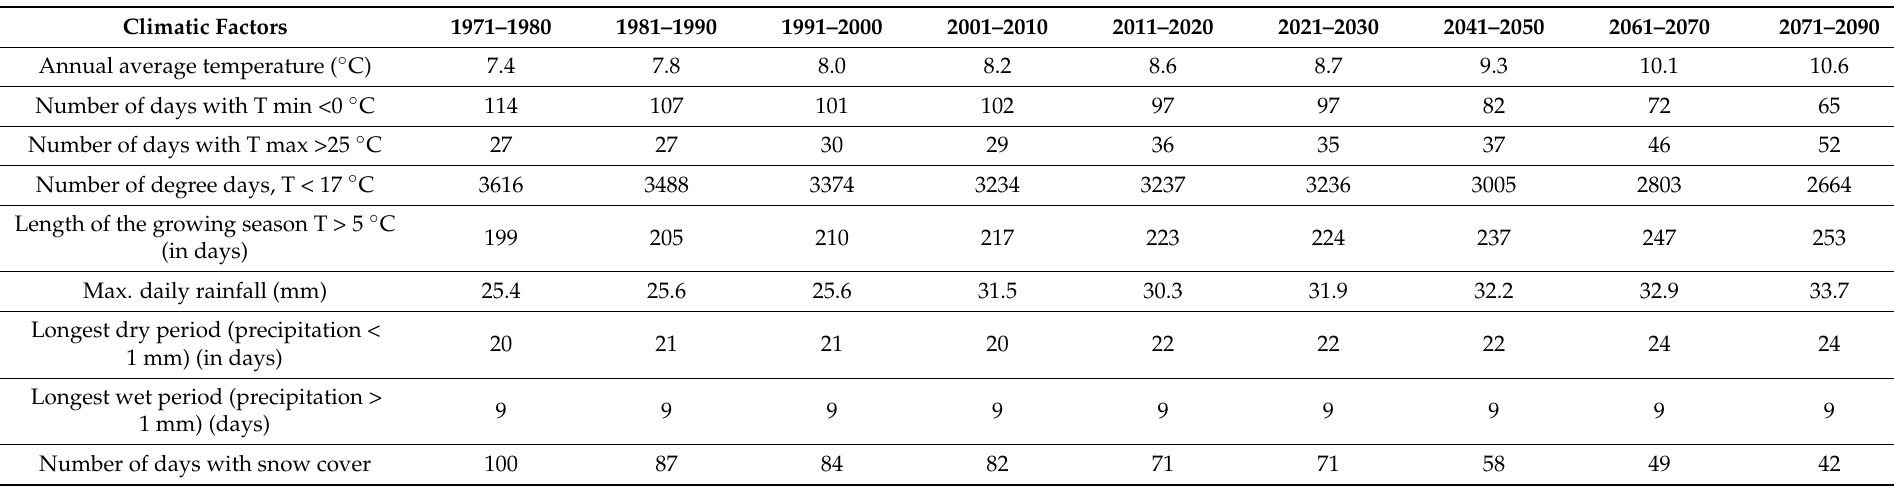
Table 1. Changes in climatic factors which have occurred in the area of Poland and which are likely to occur by 2090, on the basis of climate research data 1 . Climatic